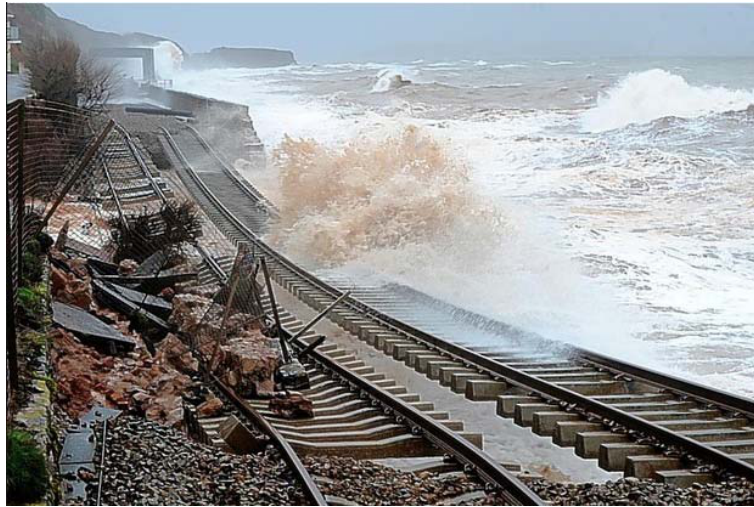
Figure 16. The main railway line to Cornwall and Devon was demolished at Dawlish by storms, which hit the UK in February 2014 (Courtesy: Network Rail).